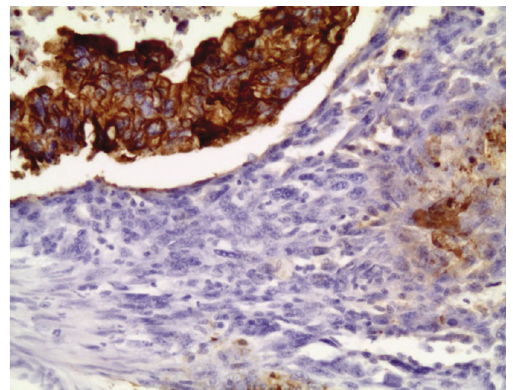
Figure 3: Immunohistochemical findings. CK7 positive tumor